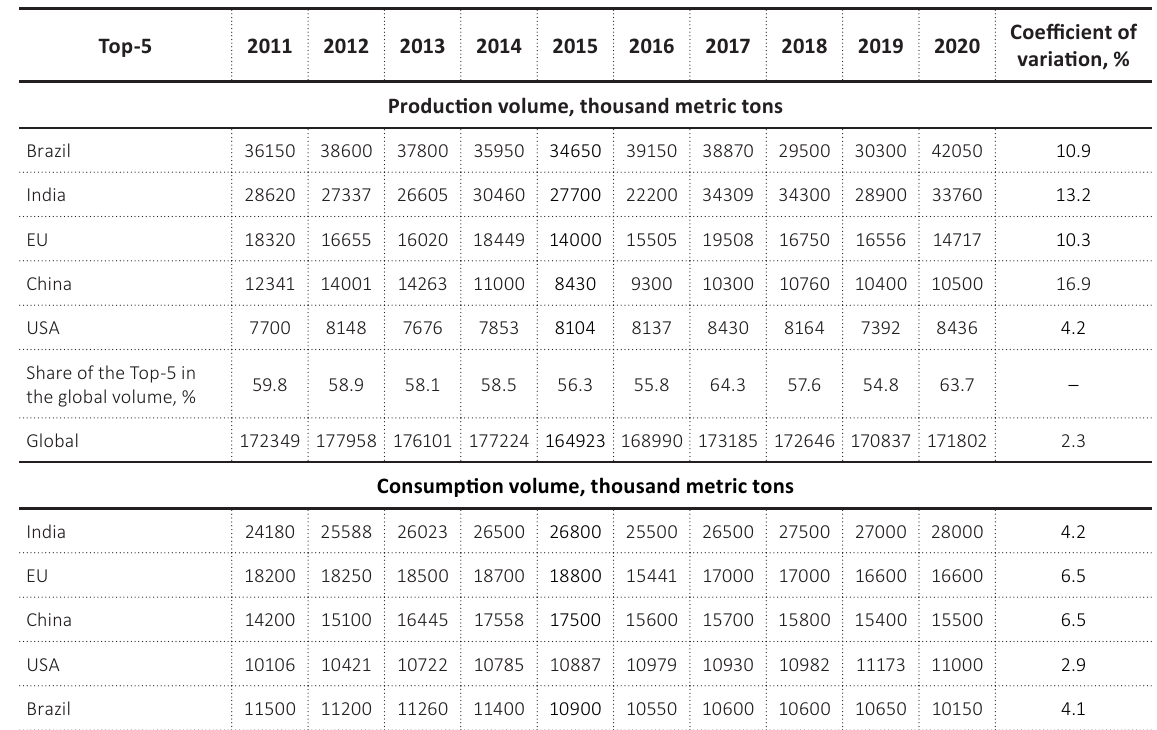
Source: U. S. Department of Agriculture